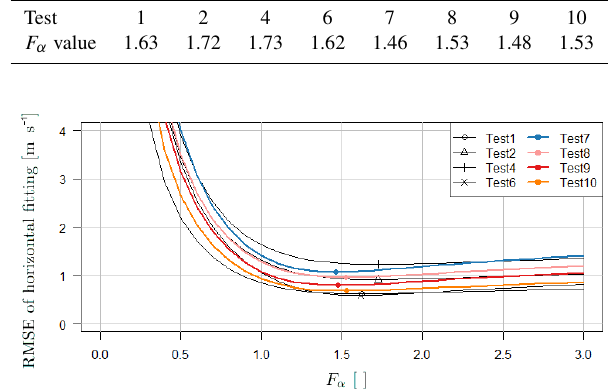
Figure 5. Root mean square error as a function of F α . Markers lo- cate the minimum value of RMSE and the corresponding F α value. Bold coloured lines are tests performed for the exact same rotor po- sition.